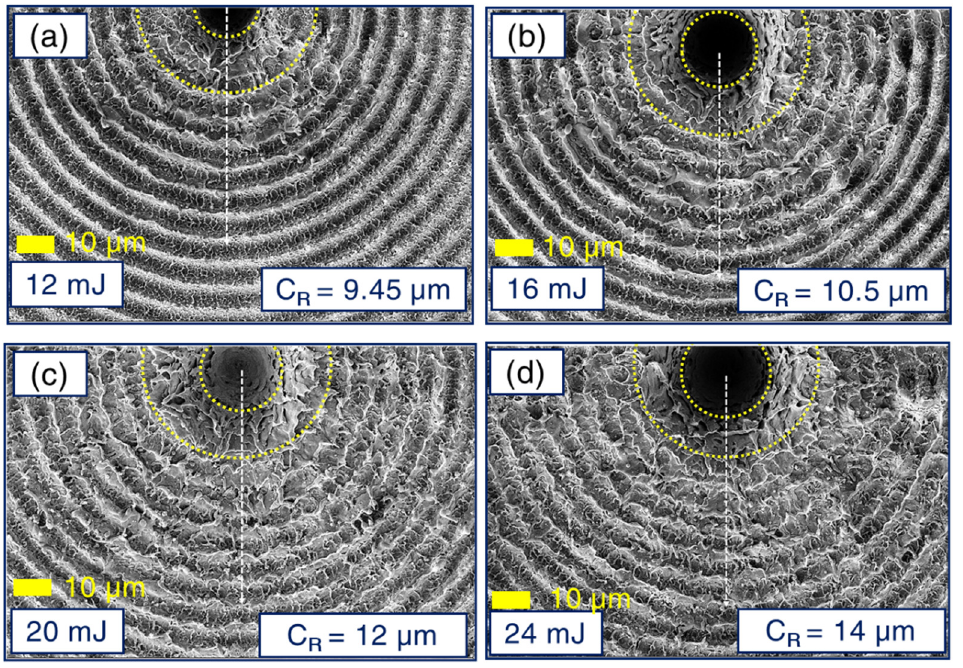
Figure 2. Bessel profile imprints on the Ag substrate in identical experimental and substrate surface conditions with varying pulse energies ( a ) 12 mJ, ( b ) 16 mJ, ( c ) 20 mJ, ( d ) 24 mJ. C R values represent the value of central lobe radii. The first yellow dotted line denotes the central lobe for the estimations of C R . The second yellow dotted line exhibits the starting of the circular pattern formations on the Ag surface due to the BB profile. The dotted line depicts the increasing ring radii. We estimated that 50 pulses were incident at this spot.